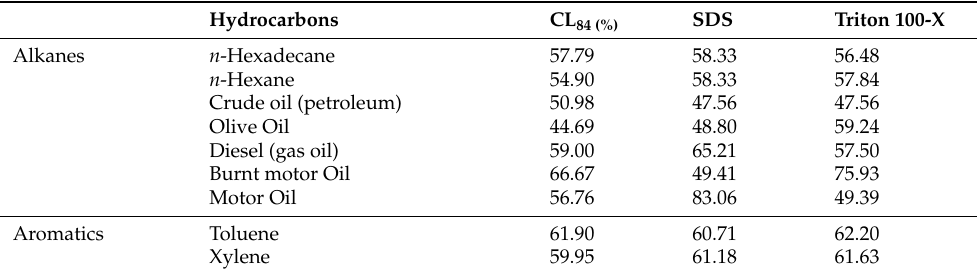
Table 7. Stability of the emulsifying activity of CL 84 under different pH, salinity and temperature conditions.